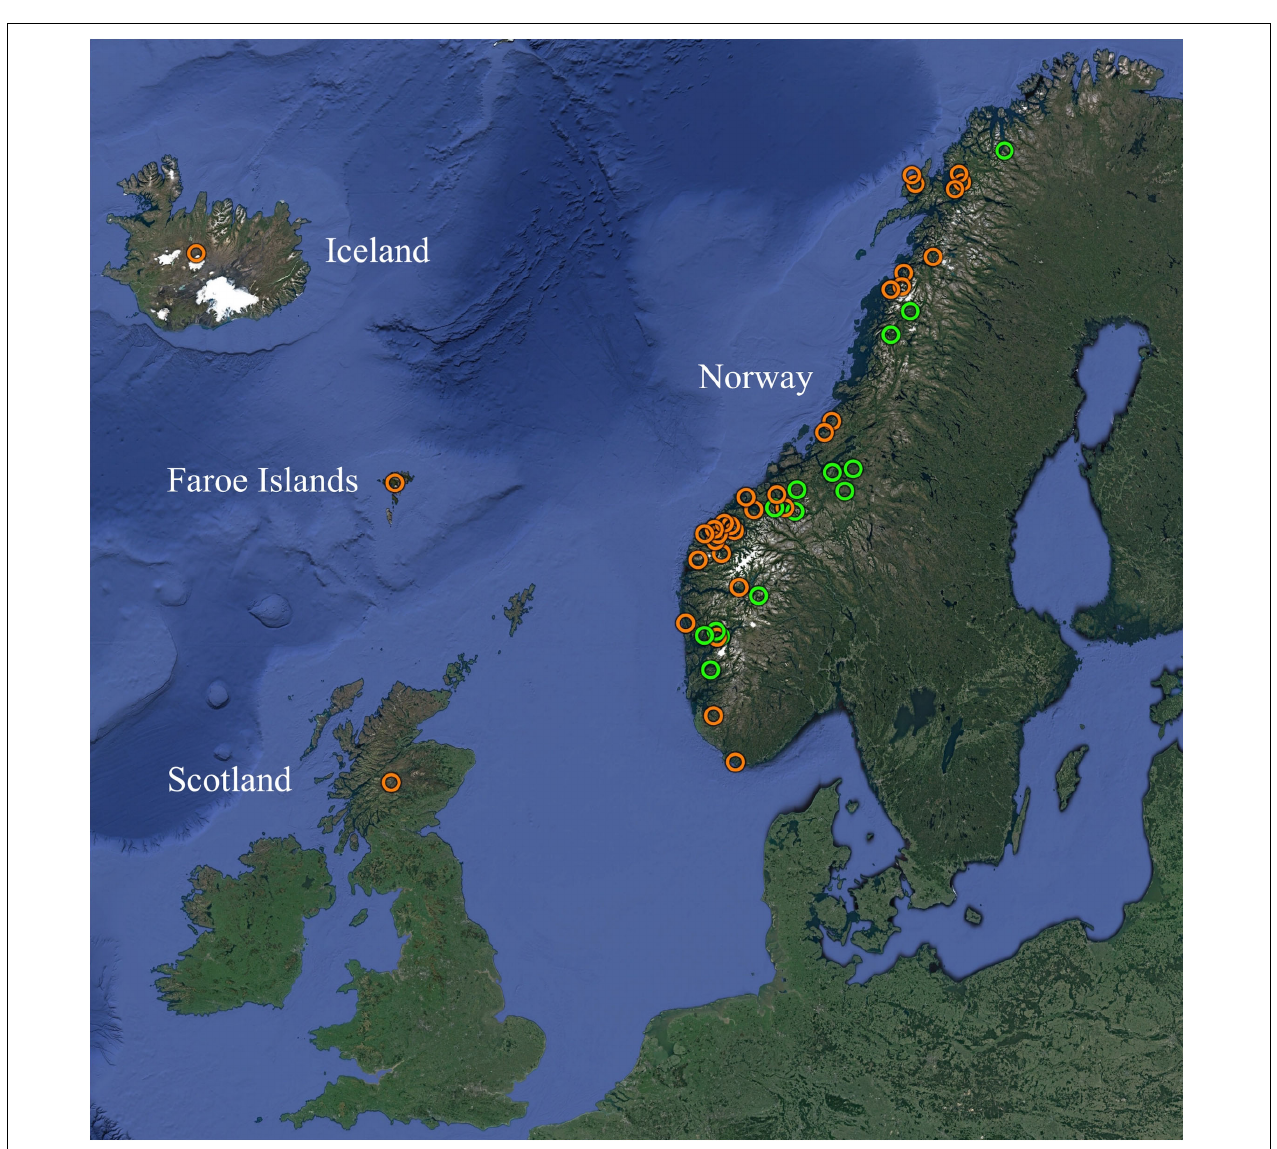
FIGURE 1 | Overview of the geographic origins of SGPV positive samples from farmed (orange) and wild (green) Atlantic salmon MLVA typed in the present study. See Table 1 and Supplementary Table S1 for further information. Map created with Google Earth (Map data/imagery: IBCAO, Landsat/Copernicus, SIO, NOAA, U.S. Navy, NGA, GEBCO, U.S. Geological Survey).